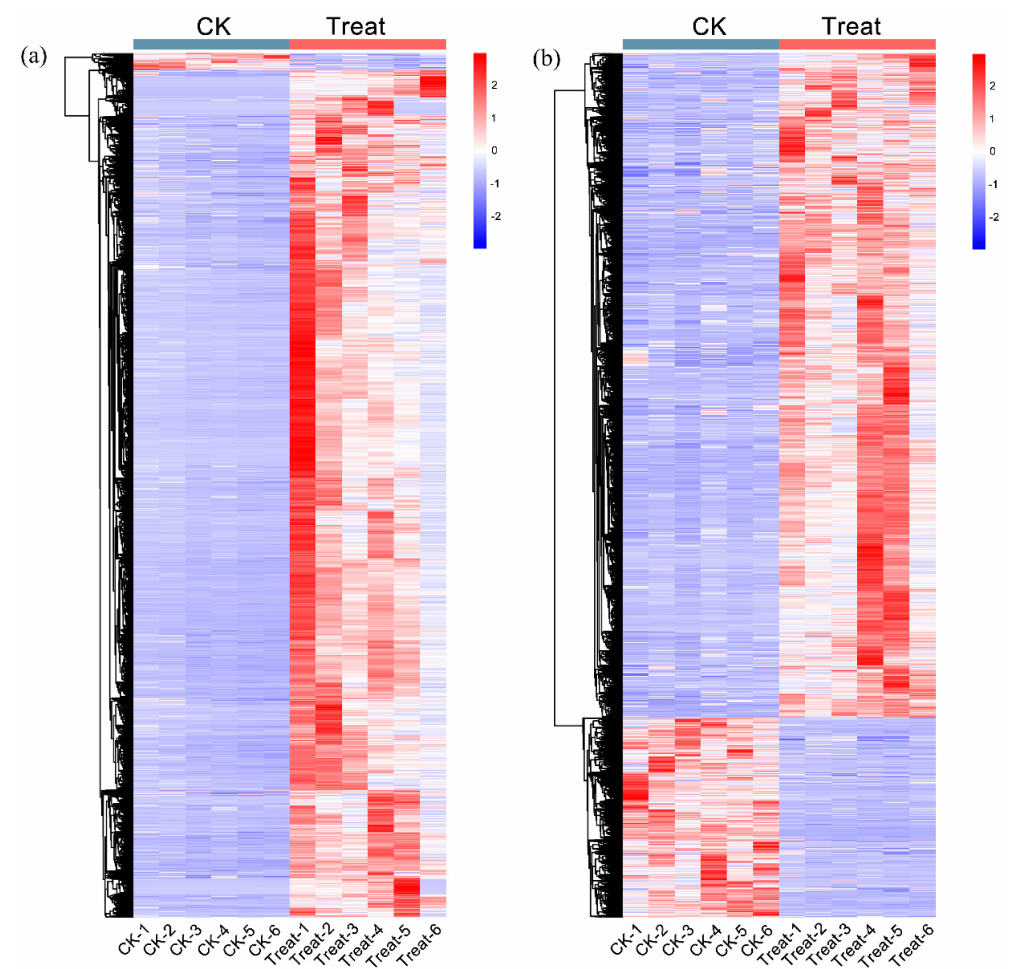
Figure 5. The differential metabolite hierarchical clustering analysis. ( a ) The differential metabolite heatmap of a positive ion. ( b ) The differential metabolite heatmap of negative ion. The magnitude of the relative amounts is shown by the difference in color, where the columns represent the samples, and the rows represent the metabolites. CK means the control group (sampled at 15 ◦ C), treat means the treatment group (sampled at − 4 ◦